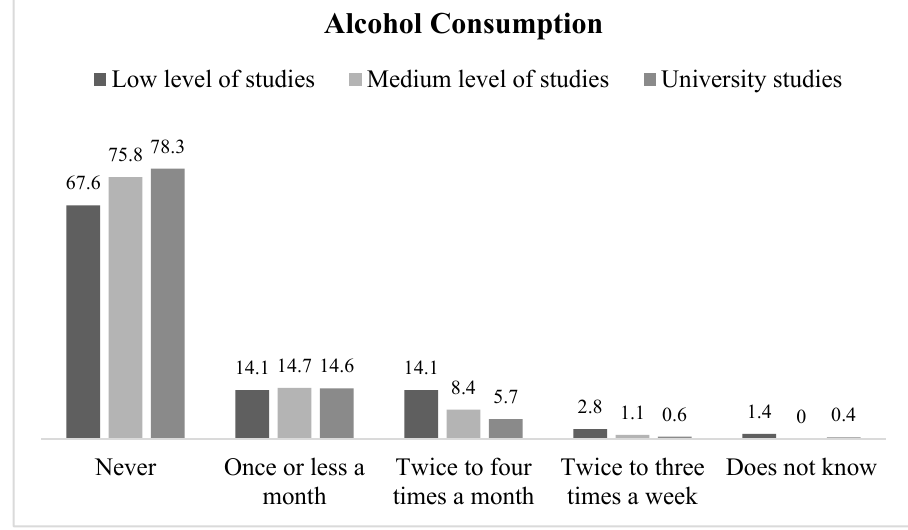
Figure 4. Frequency of alcohol consumption during pregnancy by educational level.